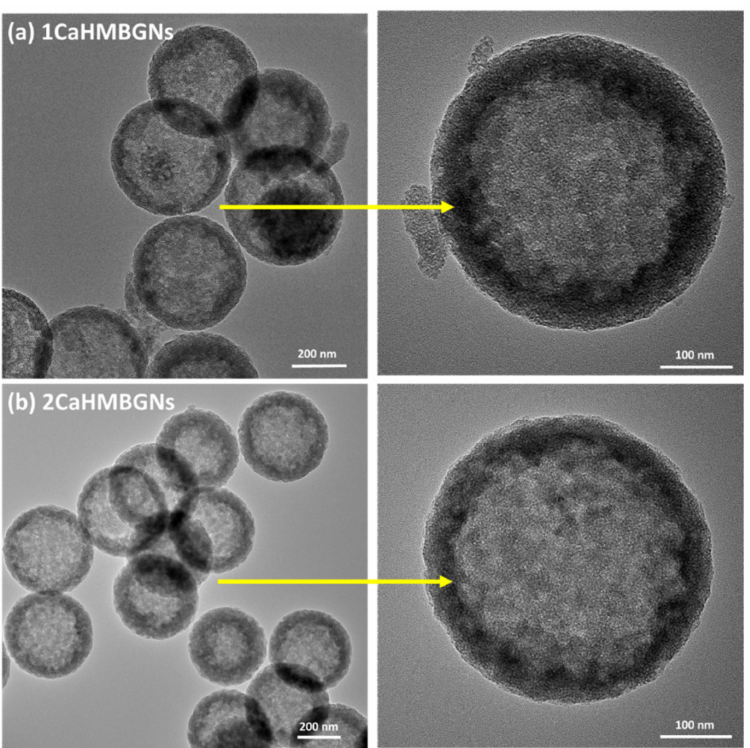
Figure 3. TEM images of hollow mesoporous bioactive glass particles: ( a ) 1CaHMBGNs and ( b )